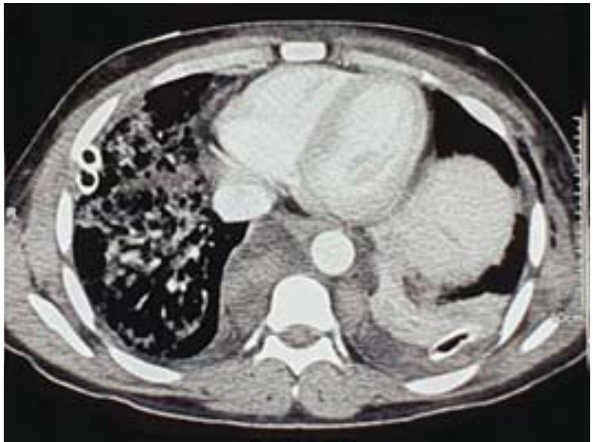
Figure 3. Post-operative CT showing intact graft, no (cid:86)(cid:76)(cid:74)(cid:81)(cid:76)(cid:191)(cid:70)(cid:68)(cid:81)(cid:87)(cid:3) (cid:70)(cid:82)(cid:79)(cid:79)(cid:72)(cid:70)(cid:87)(cid:76)(cid:82)(cid:81)(cid:3) (cid:76)(cid:81)(cid:3) (cid:87)(cid:75)(cid:82)(cid:85)(cid:68)(cid:70)(cid:76)(cid:70)(cid:3) (cid:70)(cid:68)(cid:89)(cid:76)(cid:87)(cid:92)(cid:15)(cid:3) (cid:85)(cid:76)(cid:74)(cid:75)(cid:87)(cid:3)